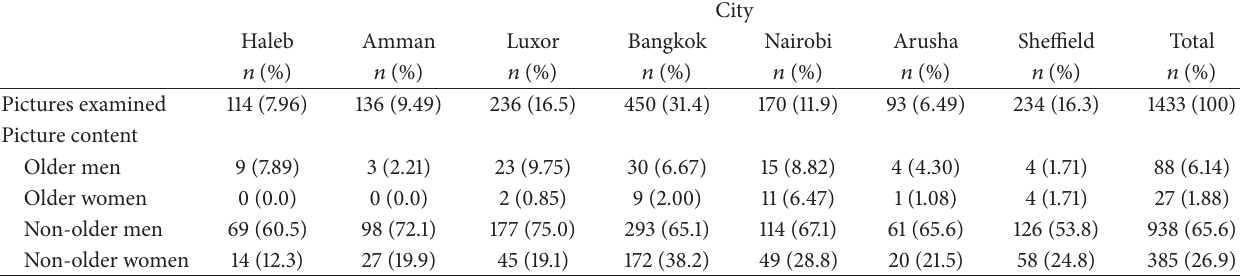
Table 3: Images of people by age and gender in pictures in newspapers from seven